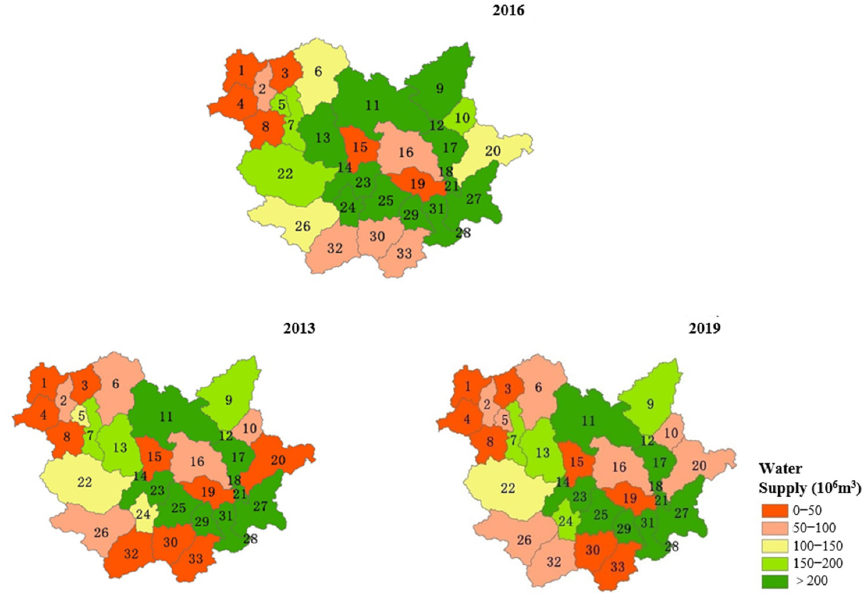
Figure 9. Spatial distribution of water supply services in the Jinjiang watershed in 2013, 2016, and 2019.